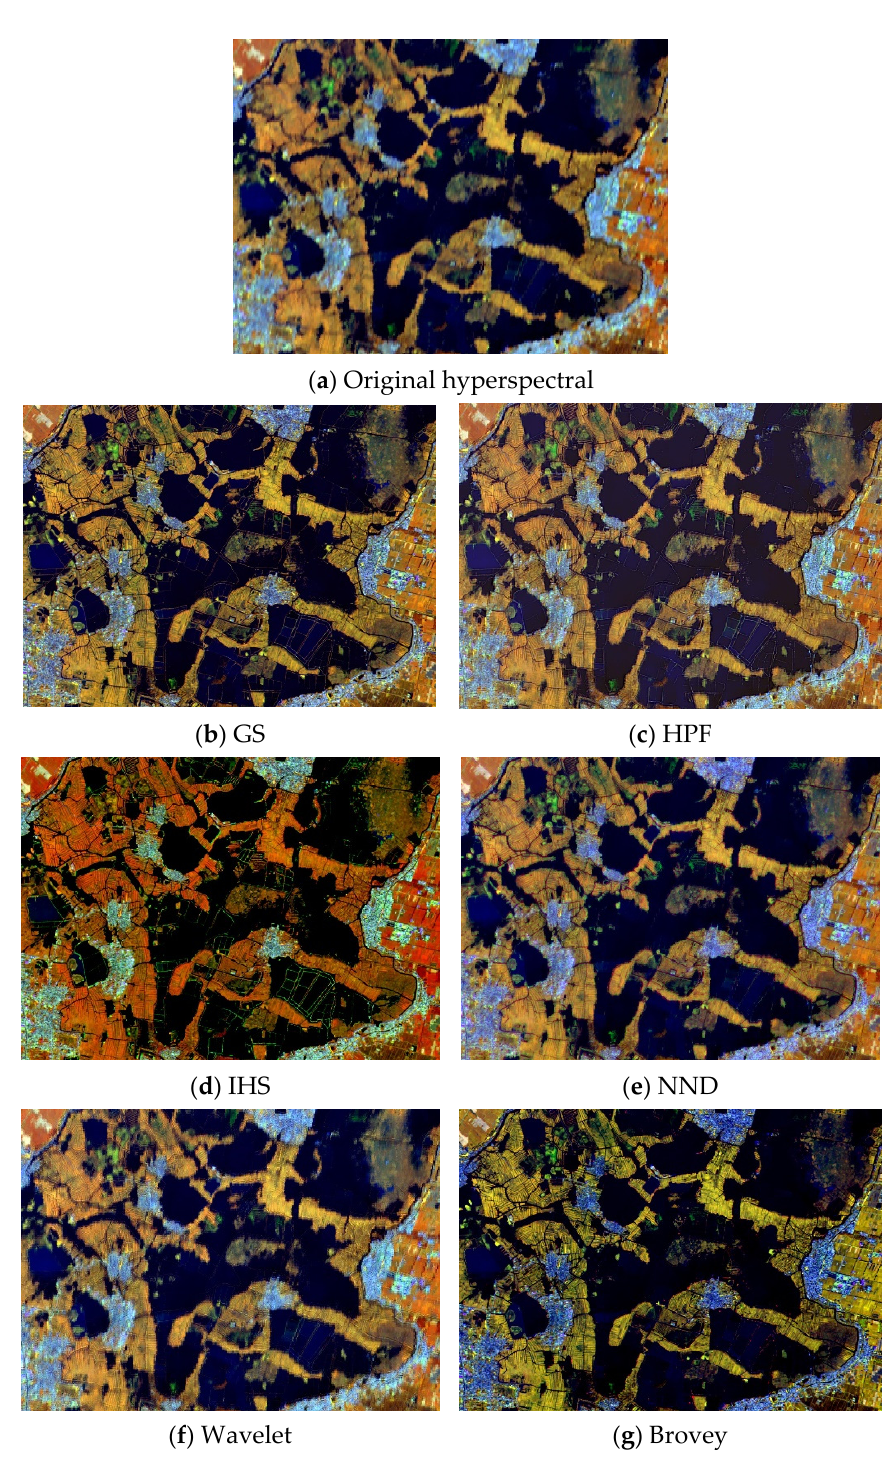
Figure 7. The details of vegetation and water.( a ) ZY-1 02D original hyperspectral image; ( b ) GS image; ( c ) HPF image; ( d ) IHS image; ( e ) NND image; ( f ) Wavelet image; ( g ) Brovey image.